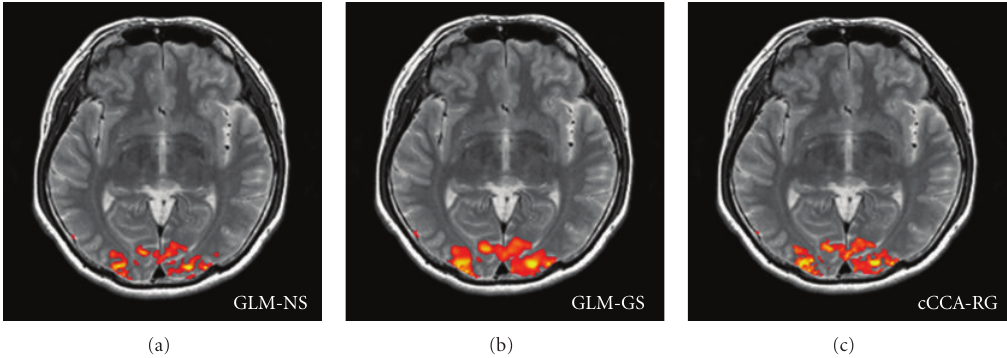
Figure 7: Activation maps for the contrast V-F of the visual paradigm using corrected P -values ( P < 0 . 05). The GLM-GS method yields the smoothest activation map at the expense of showing activations reaching outside of gray matter. The GLM-NS method preserves activations in gray matter much better but with unappealing broken links among activated voxels. The activation map using cCCA-RG provides a compromise between the smooth appearance of activations and preservation of fine cortical structure.